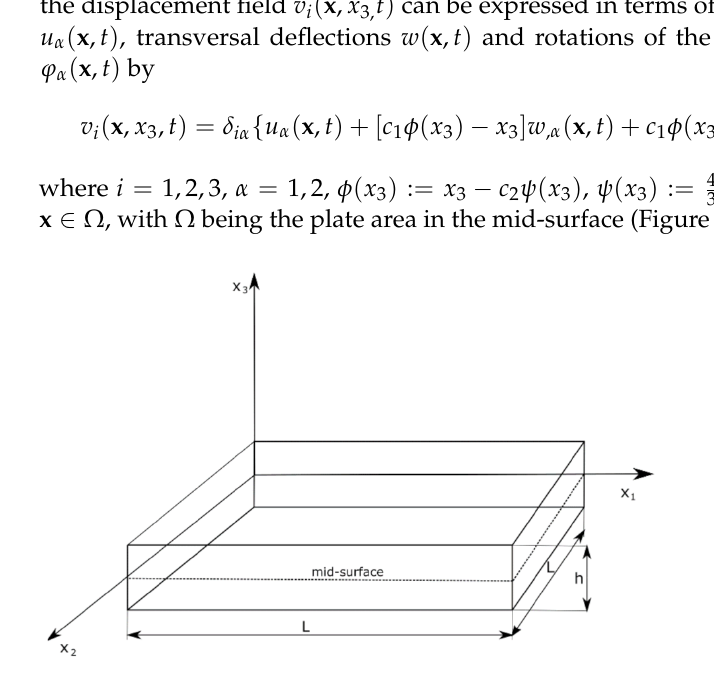
Figure 1. Sketch of a square